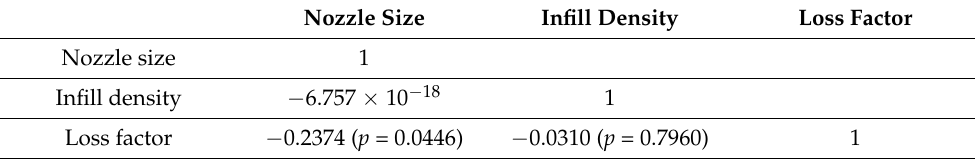
Table 5. Correlation analysis results for nozzle size/infill density and loss factor.